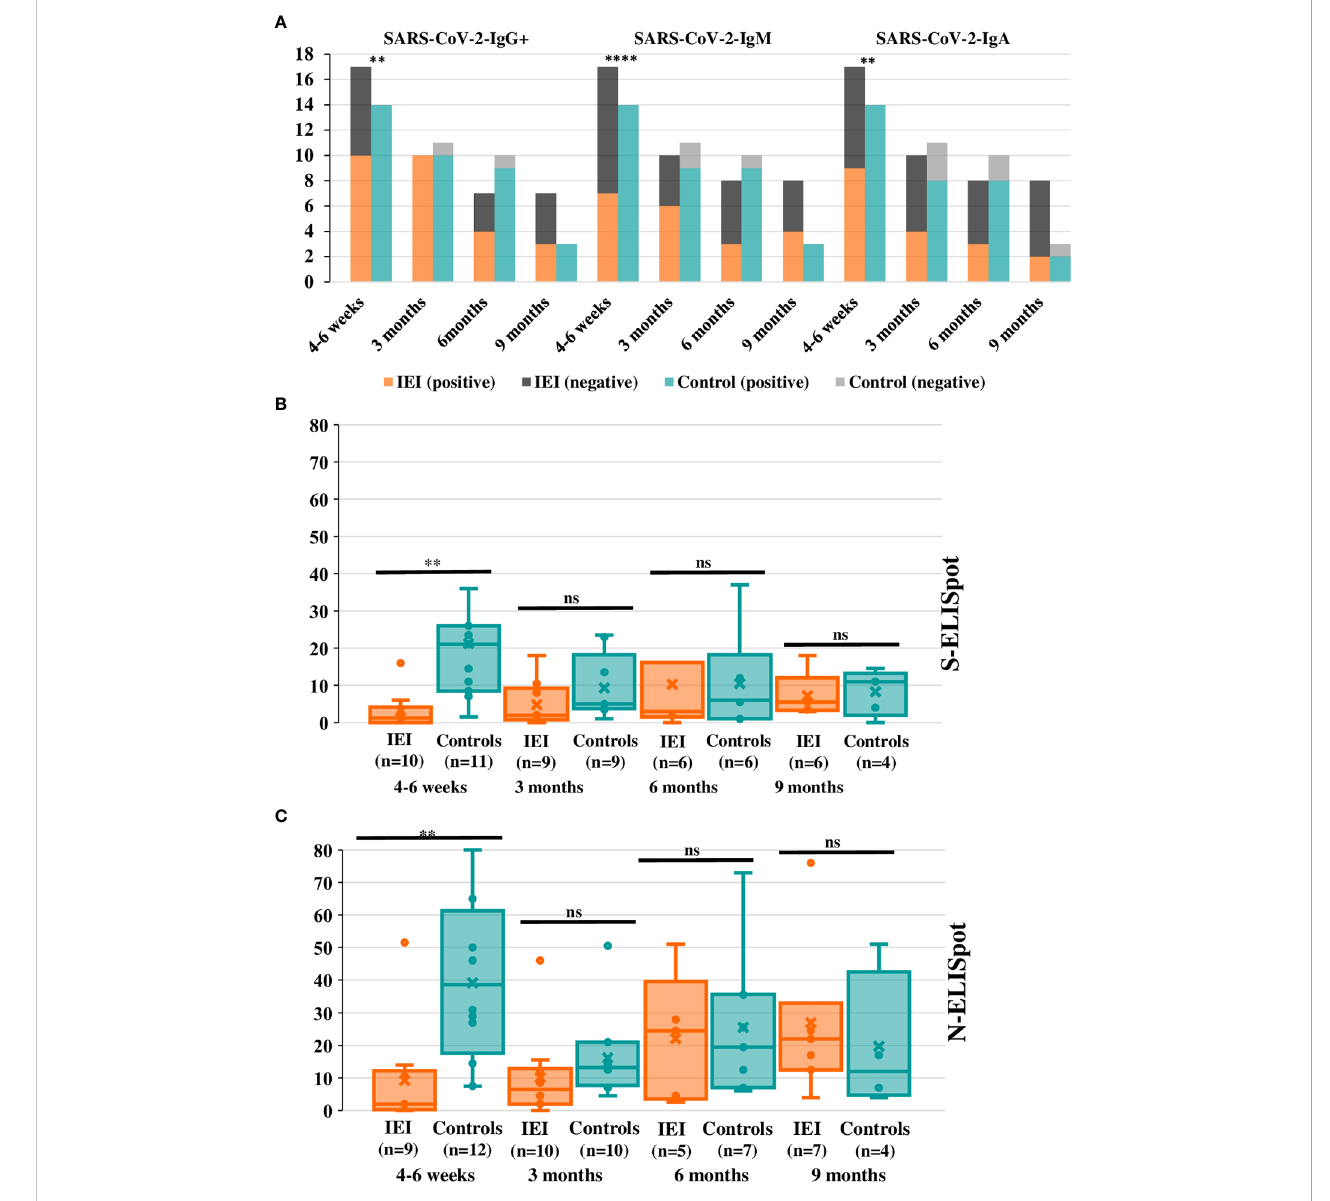
FIGURE 3 Positive serology and ELISpot indexes in cases and controls during the long-term phase post-SARS-CoV-2 infection. (A) Positive and negative SARS- CoV-2 speci fi c IgG + , IgM + , and IgA + are represented in the bars for IEI patients and controls. Only statistically signi fi cant differences are shown (*p ≤ 0.05, **p ≤ 0.01, ***p ≤ 0.001, ****p ≤ 0.0001). (B) S-ELISpot index comparison in cases-controls during the long-term period after the infection. There are two extreme values that are not represented in the box-plot graphic: ELISpot index for a control at 4-6 weeks: 63; ELISpot index at 6 months for P15: 48. (C) N-ELISpot index in cases and controls during the long-term follow-up. For (B, C) the box horizontal middle line represents the median, the extremes represent lower quartile (Q1) and higher quartile (Q3); maximum and minimum values (without outliers) are represented by the horizontal lines in the extremes of the whiskers. The individual values between quartile 1 and 3 are represented by dots; the mean is represented by an “ x ” symbol. For all panels signi fi cance levels are marked as *p ≤ 0.05, **p ≤ 0.01, ***p ≤ 0.001, ****p ≤ 0.0001, ns: